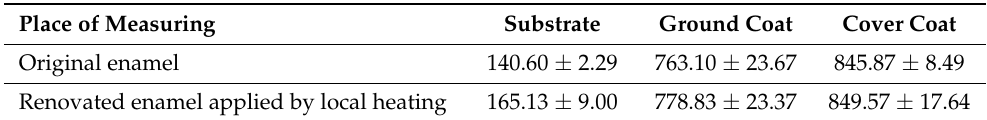
Table 1. Microhardness measurement HV0.05 (10 s load) for original enamel and renovated enamel applied by local